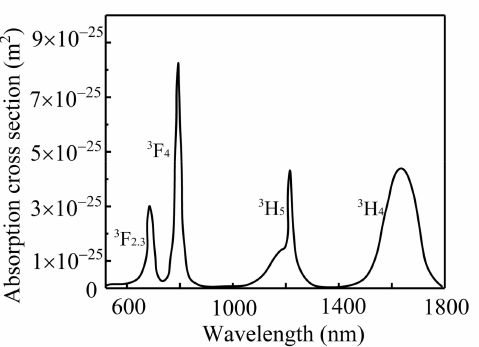
Figure 1. Absorption spectrum of thulium